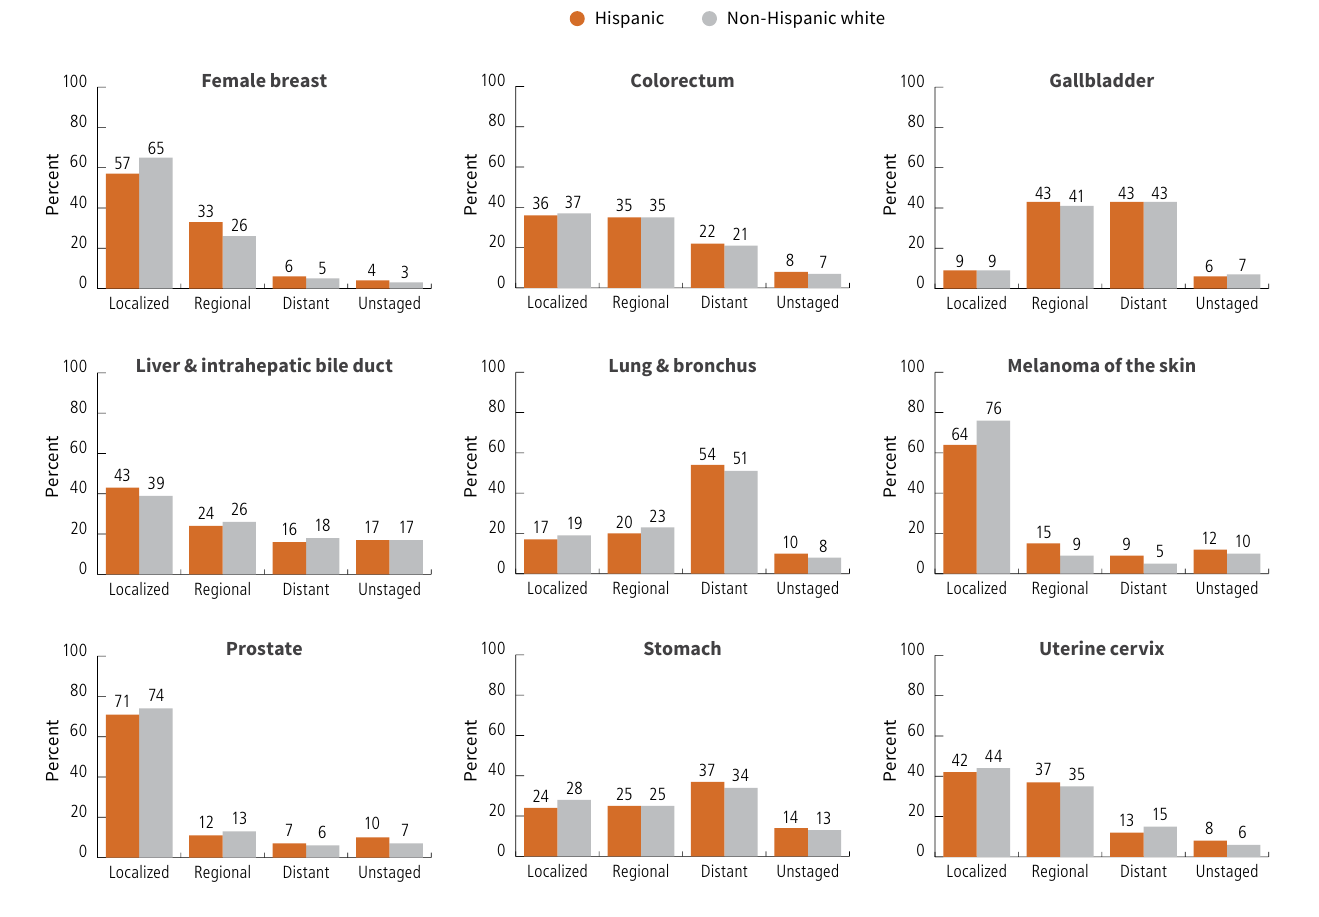
Percentages may not total 100 due to rounding. Data exclude Puerto